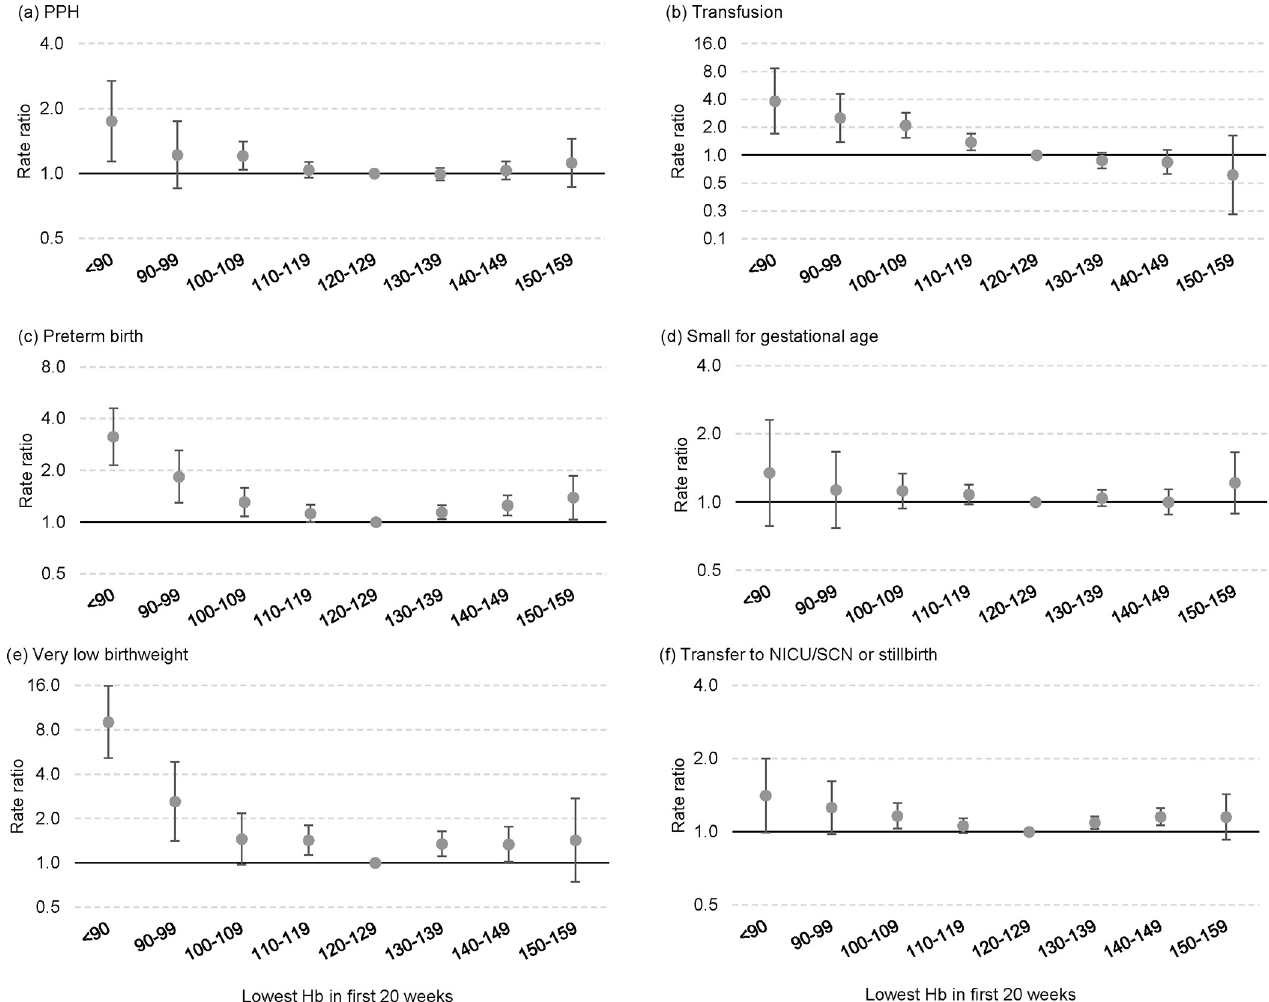
Fig 2. Adjusted rate ratios for individual outcomes by lowest haemoglobin (Hb) at 20 weeks gestation or less.